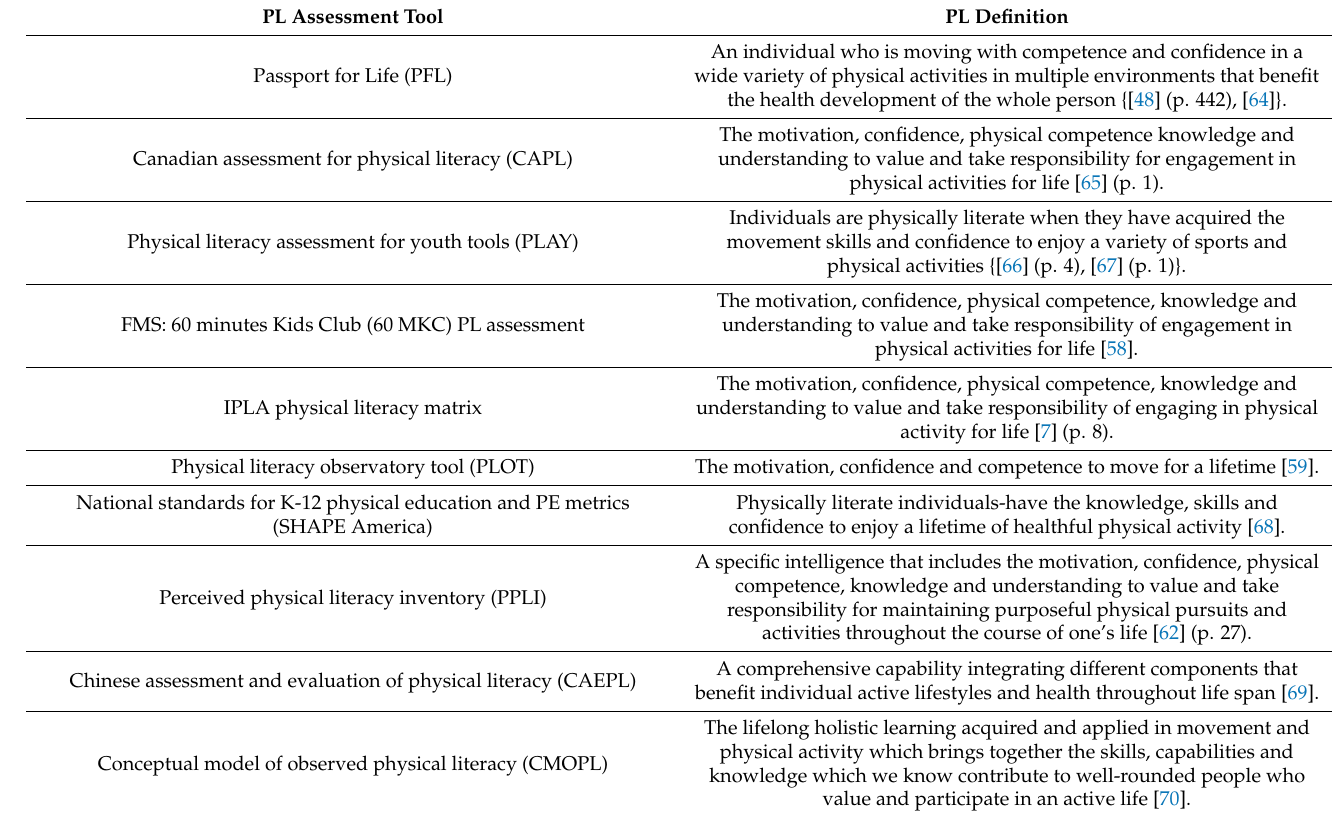
Table 2. Physical literacy assessment tools and their corresponding guiding PL